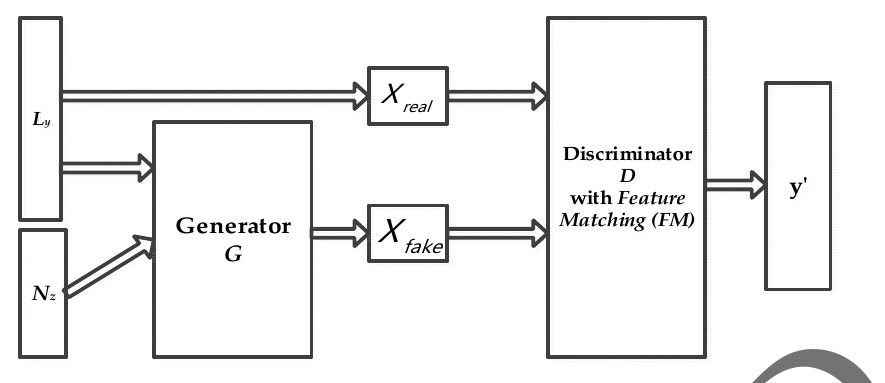
Figure 5. The CP-ACGAN network structure.